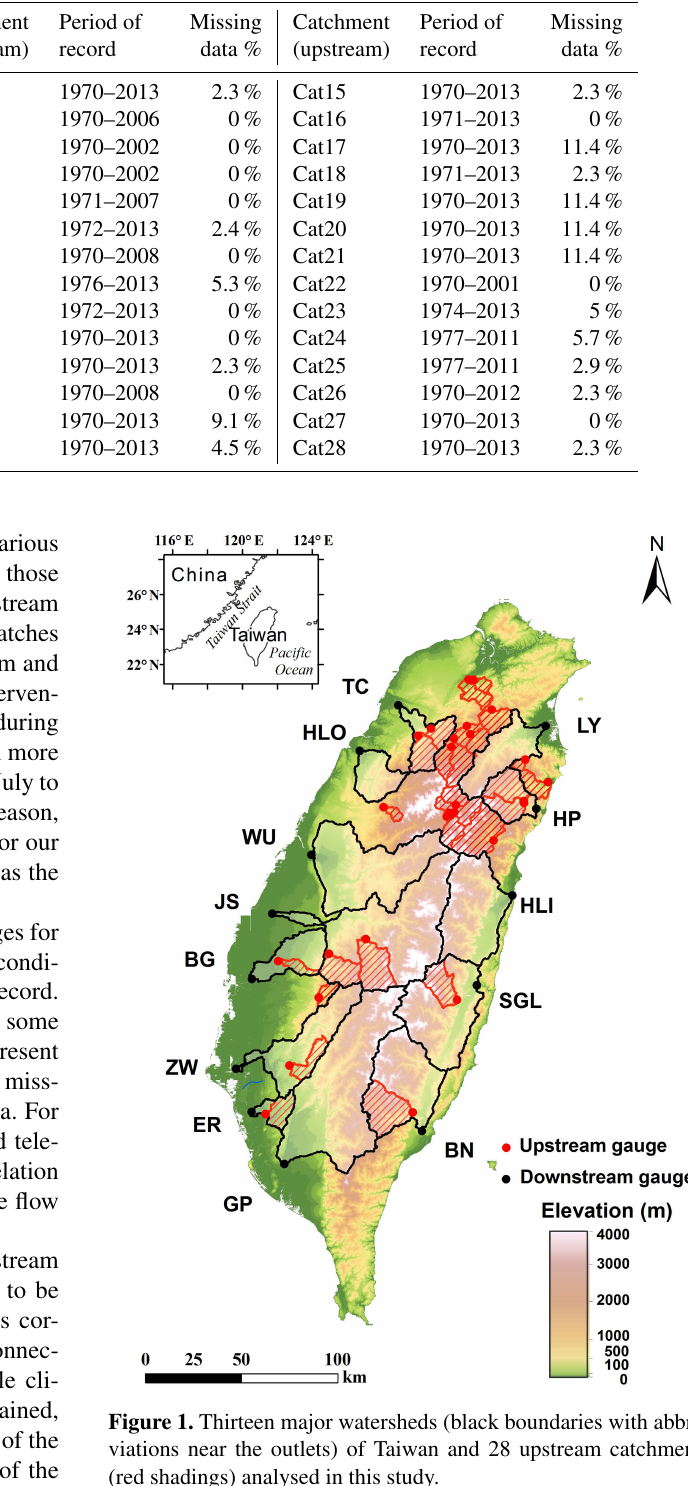
Table 1. Periods of data record and missing data percentages for all 41 catchments used for our analysis. Note that we use only JAS data in each year, and the missing data percentage is referred to as the percentage of years in which no JAS data are available.